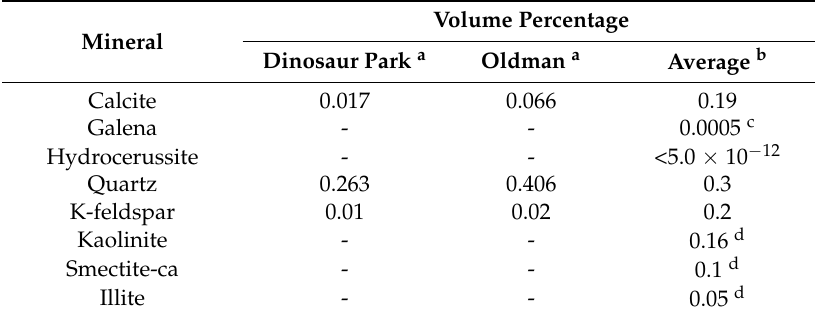
Table 4. Mineral components and abundance in